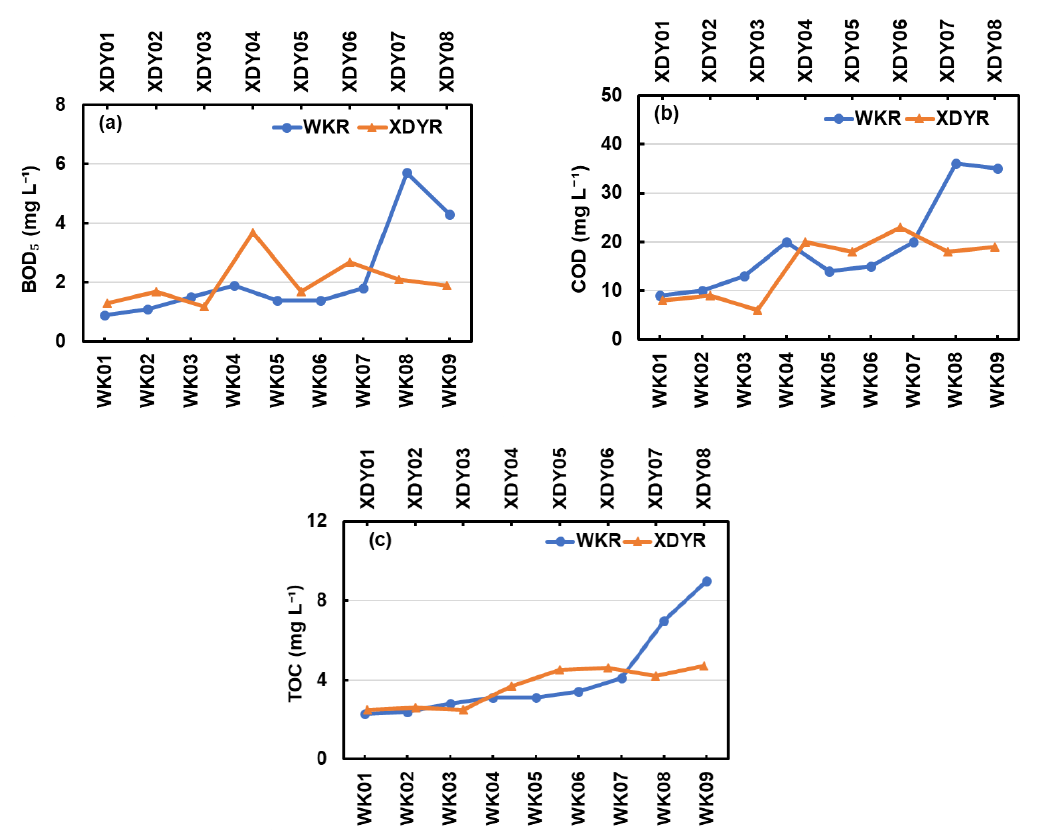
Figure 3. Spatial distribution of ( a ) biological oxygen demand over 5 days (BOD 5 ), ( b ) chemical oxygen demand (COD), and (c) total organic carbon (TOC) of the sampling sites in the WangKuai reservoir route (WKR) and XiDaYang reservoir route (XDYR).